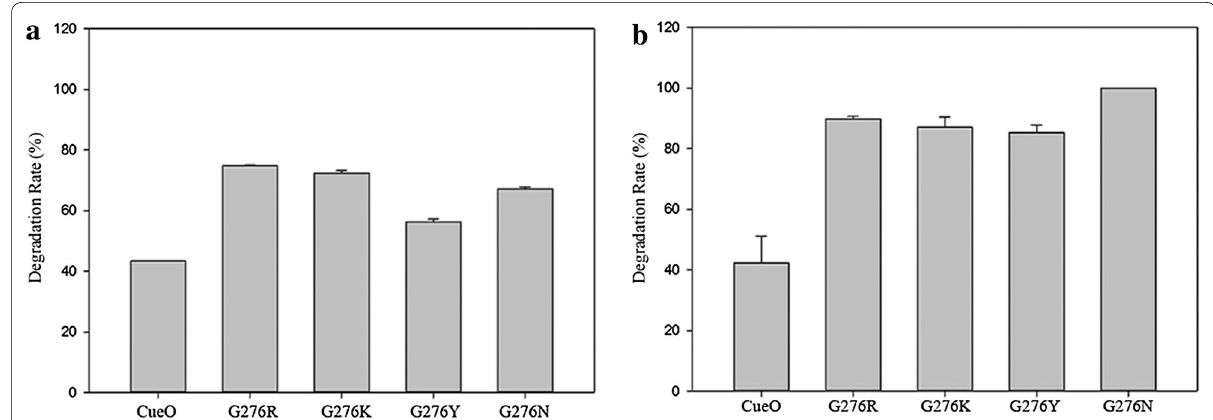
Fig. 7 Oxidation of benzo[α]pyrene by CueO and its mutants at a pH 3.5 and 30 °C, and b pH 3.5 and 60 °C. The reaction system contains 0.3 ppm benzo[α]pyrene and 200 μg laccase per milliliter (30 °C) or 4 μg laccase per milliliter (60 °C) and ABTS (0.5